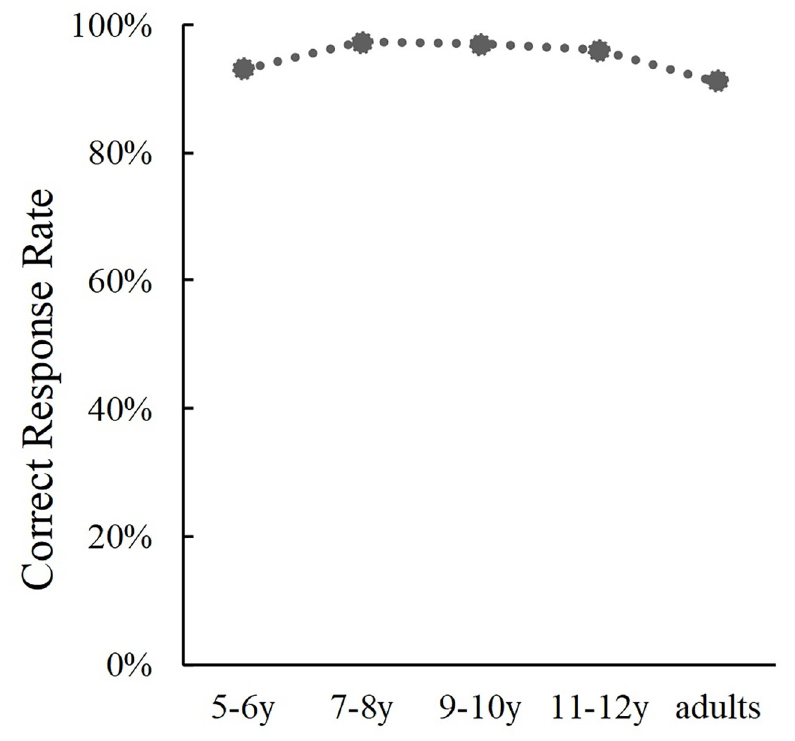
Fig 4. Developmental changes in correct response rates in the emotion perception task.